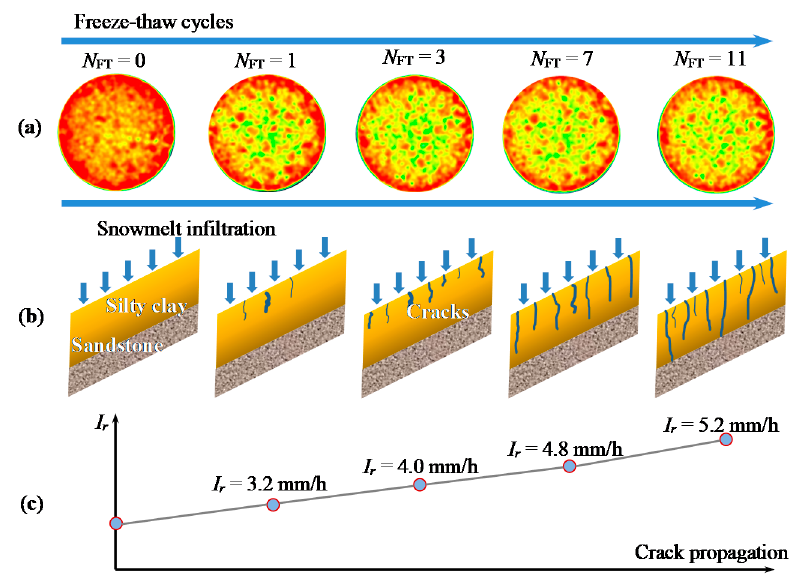
Figure 16. Schematic view of the crack propagation in soil slope: ( a ) CT images of silty clay after various freeze-thaw (F-T) cycles [10]; ( b ) crack propagation in the surface of soil slope (after [17]); and ( c ) SWE rainfall intensity ( I r ) for soil slope exposed to different F-T cycle. The effective cohesion ( c (cid:48) ) and effective internal friction angle ( ϕ (cid:48) ) obtained from the laboratory tests are plotted in Figure 18 with respect to the number of F-T cycles ( N FT ). We note that both c (cid:48) and ϕ (cid:48) decrease with increasing N FT , indicating that the shear strength of the soil decreases with increasing N FT